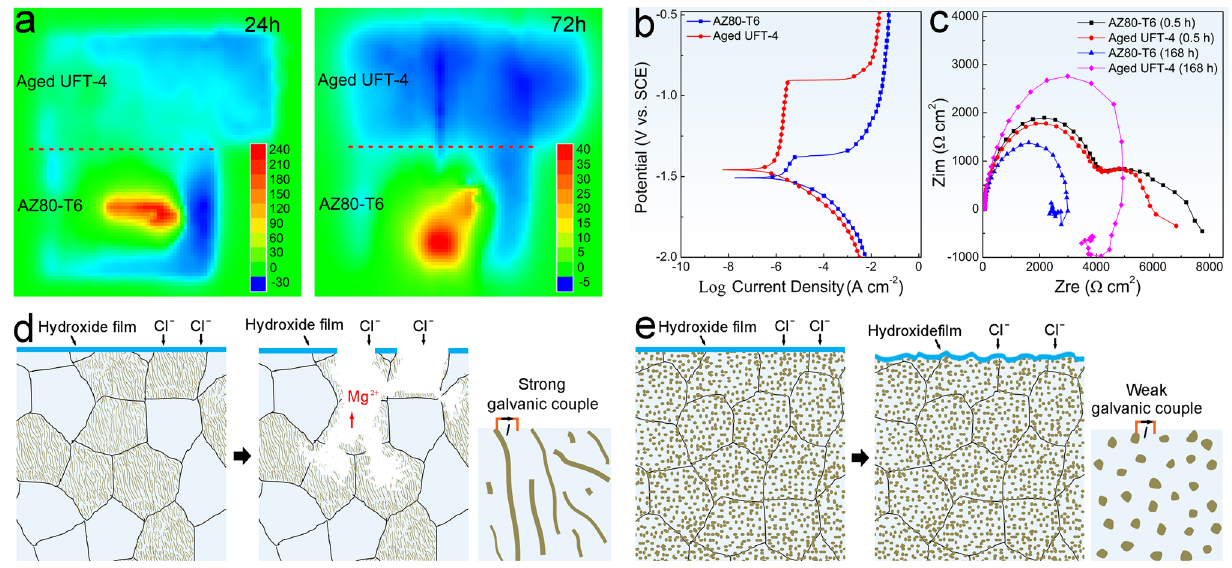
Fig. 6 Electrochemical corrosion characteristics and corrosion mechanism. a SVET measurement of the coupled AZ80-T6 and aged UFT-4 after immersion for 24 h and 72 h. b Potential dynamic polarization curves and ( c ) EIS spectra of AZ80-T6 and aged UFT-4 after immersion for 0.5 h and 168 h; Schematic illustration of the corrosion mechanism: ( d ) AZ80-T6 and ( e ) aged UFT-4. SCE in ( b ) represents saturated calomel